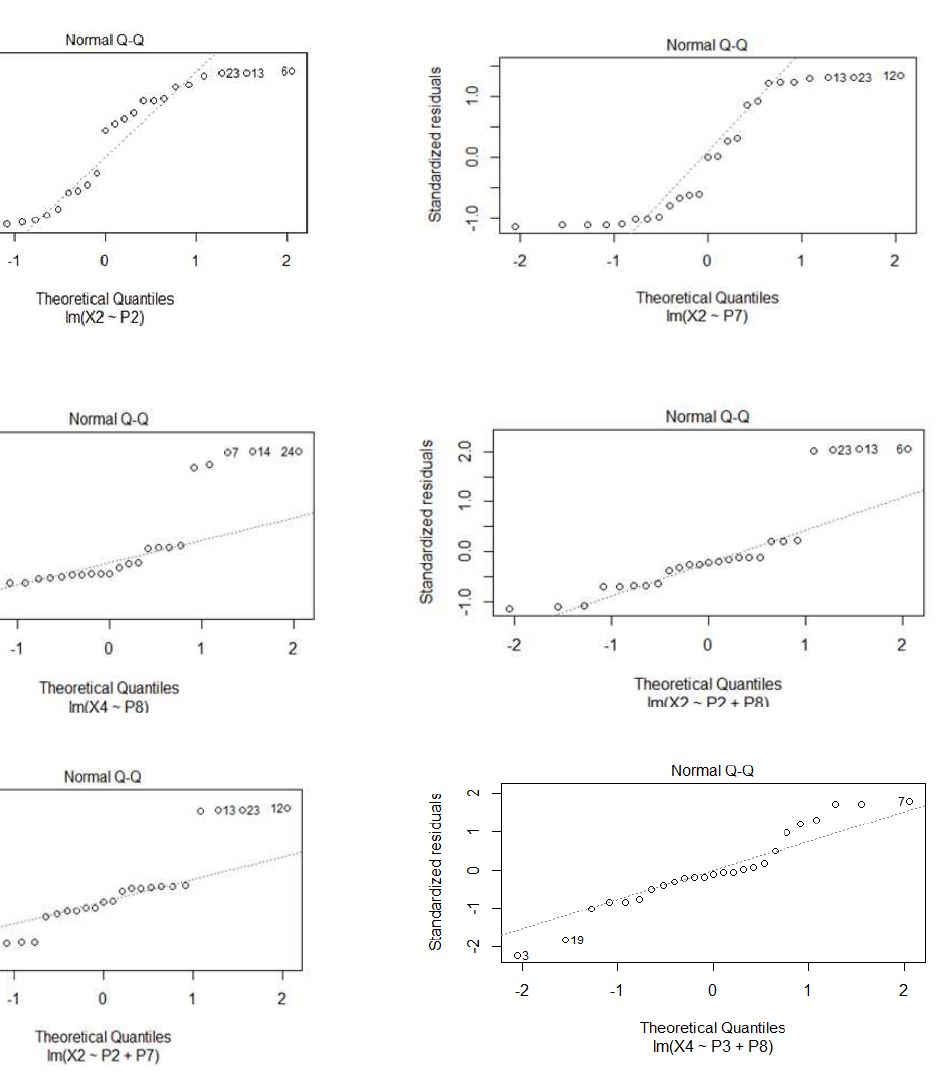
, X , X , P , P , and P 3 4 7 2 2